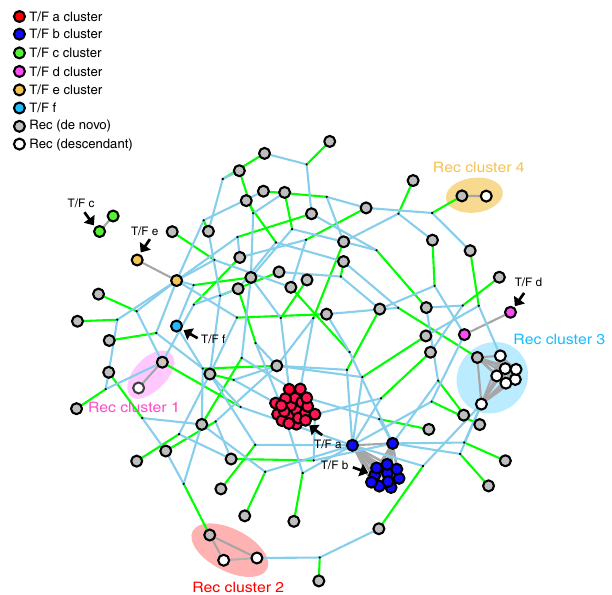
Fig. 4 Clustering graph of the 3 ′ half genome sequences from CH0010. Each circle represents a sequence, and circles of the same color represent a T/F lineage. Gray circles represent de novo recombinant sequences and open circles represent descendants of recombinant sequences. Clusters are calculated using a greedy algorithm and they originate either from a T/F lineage or through recombination across lineages. Recombination clusters are shaded and color coded to indicate their closest T/F lineage. At most one sequence per recombination cluster is called a de novo recombinant: the rest are assumed to be descendants of this recombinant sequences.